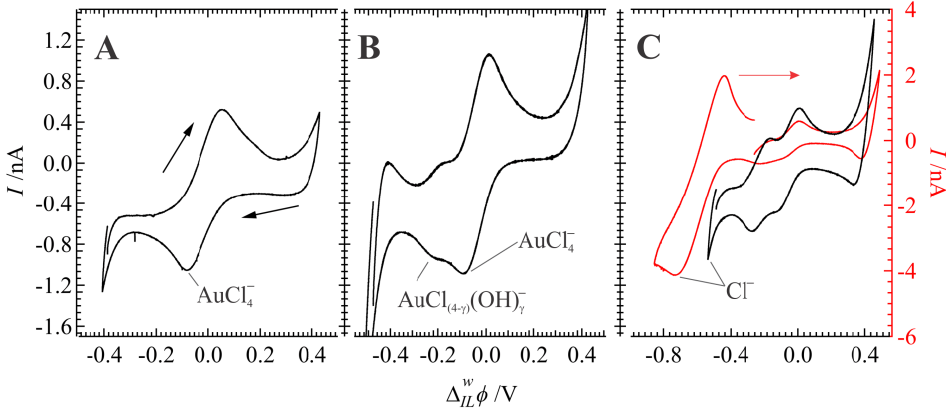
Figure 5. CV responses at a w|P 8888 TB 25 µm diameter interface described by Cells 1b – 3b in which the aqueous pH increases from 2 to 5.5 – 6 and 8.5 ( A – C ). Black and red arrows indicate the scan direction and the axes the CV is plotted against, respectively. The cell was maintained at 60 °C using a water circulator (Polystat, Cole-Parmer).